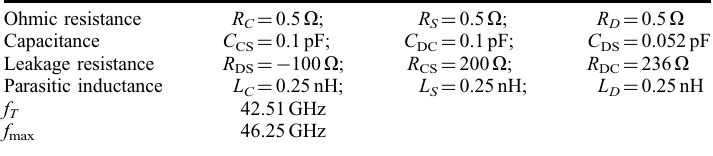
TABLE III The Improved